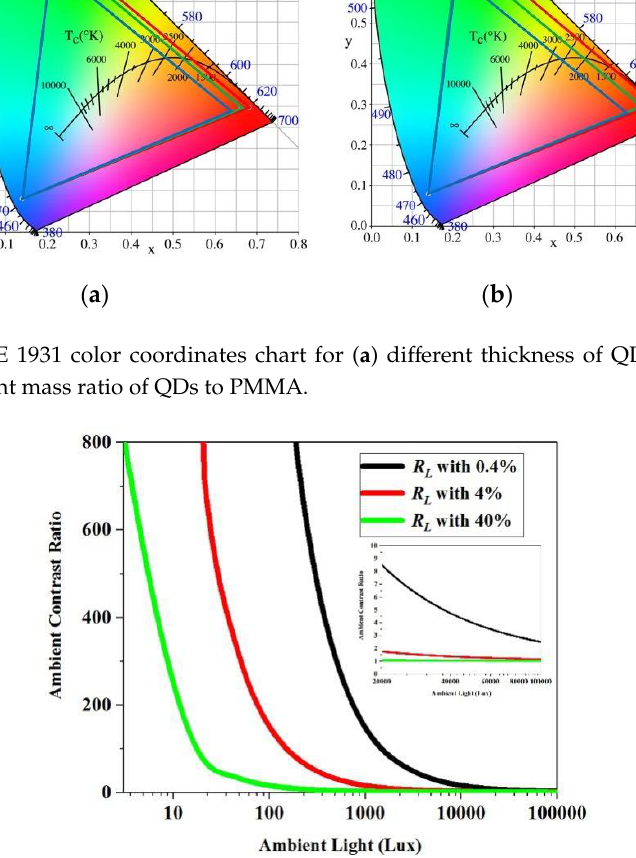
Figure 9. Simulated ambient contrast ratio with different ambient light and reflectivity.